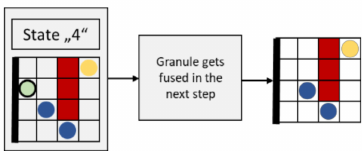
Figure 12. Flowchart for the update rule of a granule fusing with the membrane (state